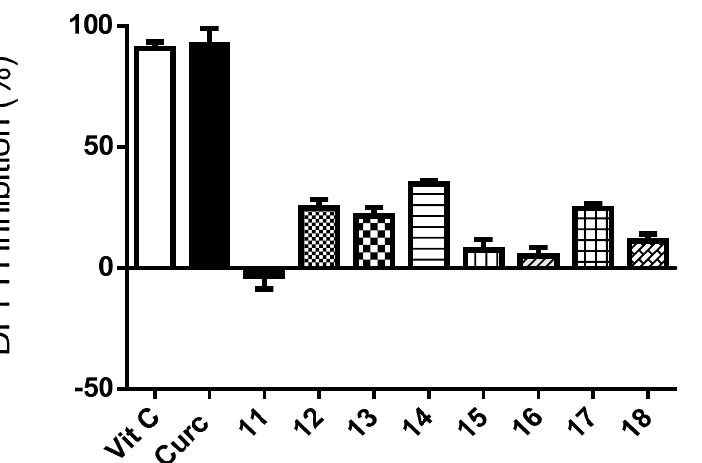
Figure 2. Percentage of neutralization of radical DPPH . by curcumin, curcumin–coumarin hybrid analogues 11 – 18 (100 µ M) and vitamin C used as reference (100 µ M). Each value is the mean ± s.e.m. of 3 experiments ( n = 3).